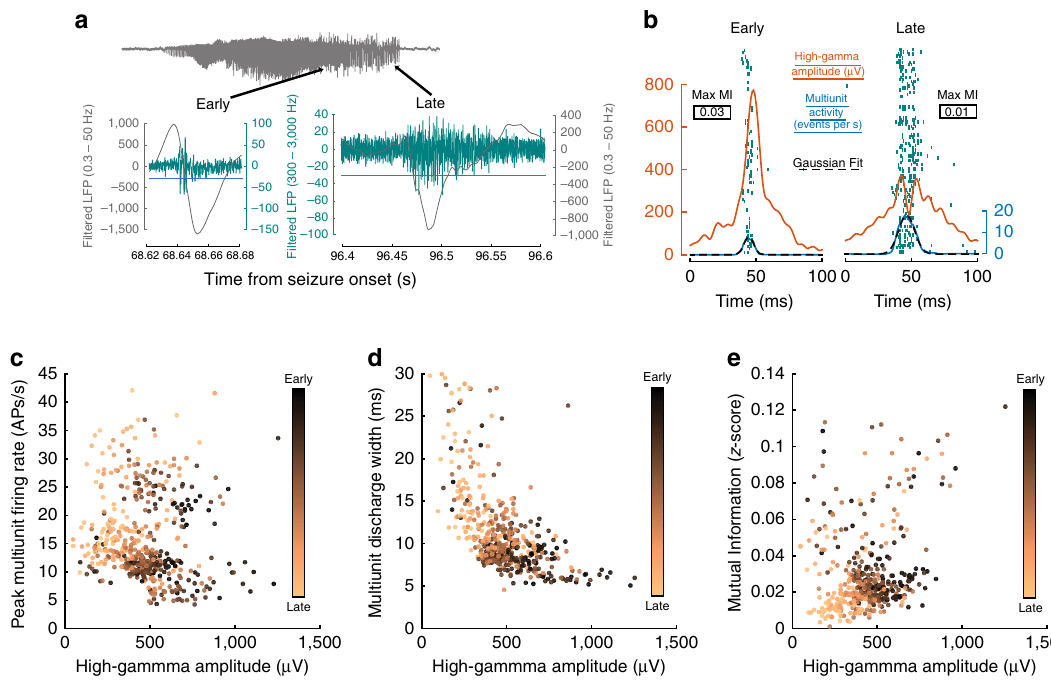
Figure 7 | Local desynchronization in the ictal core precedes seizure termination. ( a ) Examples of filtered data for two sample discharges during the pre- termination epoch. Low-frequency filtered data (0.3–50Hz) are shown in grey and filtered data for multiunit activity detection (500–3000Hz) are shown in teal. The threshold for multiunit event detection is indicated with a blue line. Bursts are indicated on the seizure in grey using black arrows. ( b ) Examples of high- g (orange), firing rate (blue) and Gaussian fit (black dotted lines) for burst width superimposed on the multiunit activity raster plot (teal) for two bursts in one seizure: one at the beginning of the pre-termination epoch (early) and one at the end of the pre-termination epoch (late). Maximum mutual information values for each discharge are shown in boxes. ( c ) Relationship between peak multiunit firing rate and peak high- g amplitude for each discharge. ( d ) Relationship between high- g amplitude and multiunit discharge width for each discharge. ( e ) Relationship between peak high- g amplitude and multiunit synchrony in each discharge. Colours in c , d , and e represent when each discharge occurred during the pre-termination epoch, with black dots occurring earlier and copper dots occurring later.